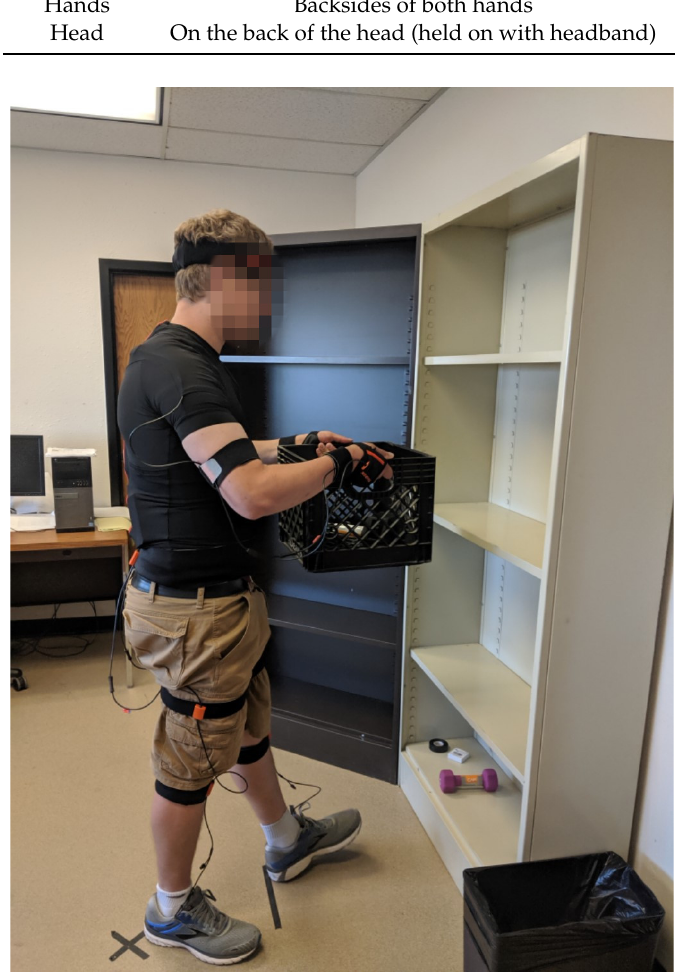
Figure 1. Participant wearing the Xsens Link system while performing a